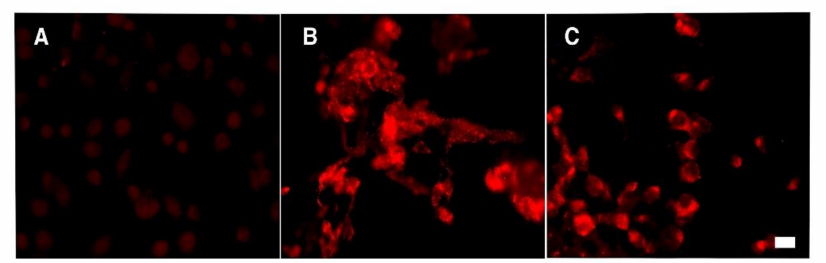
Figure 6. Nile Red NE visualization after 24 h cell treatment. Panel ( A ) control cells treated with free Nile Red. Panel ( B ) T24 cells treated with Nile Red 30 nm NEs. Panel ( C ) T24 cells treated with Nile Red 140 nm NEs. Bar, 10 µ